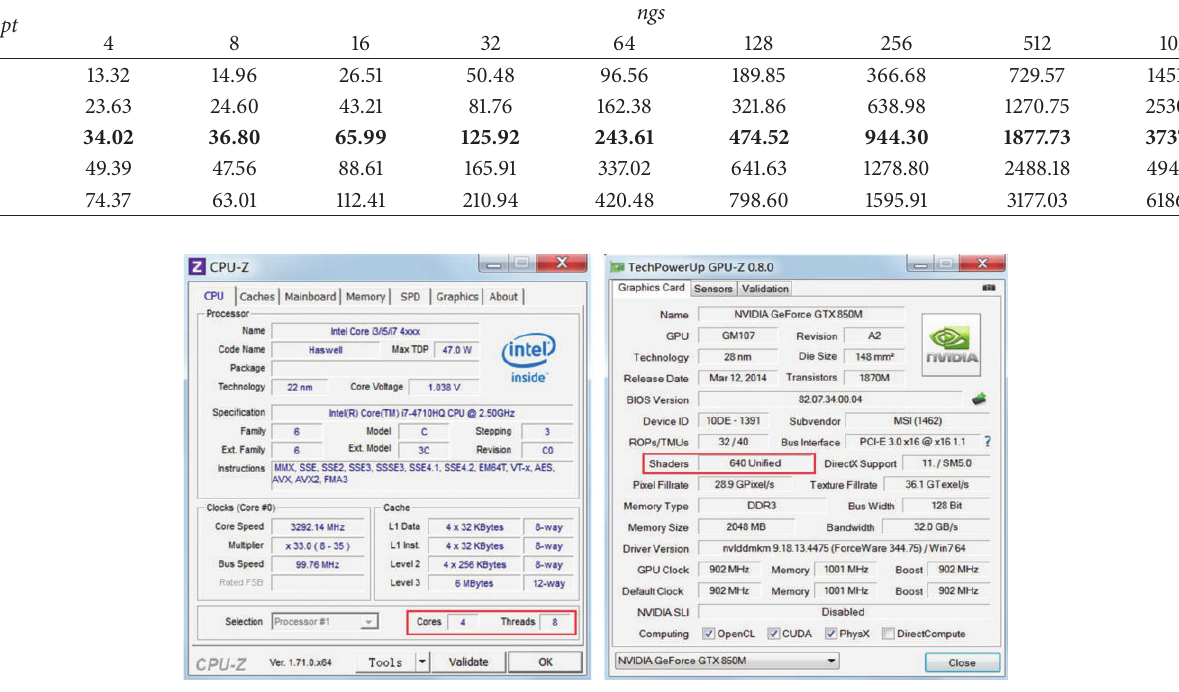
Figure 4: The CPU and GPU used in this study.